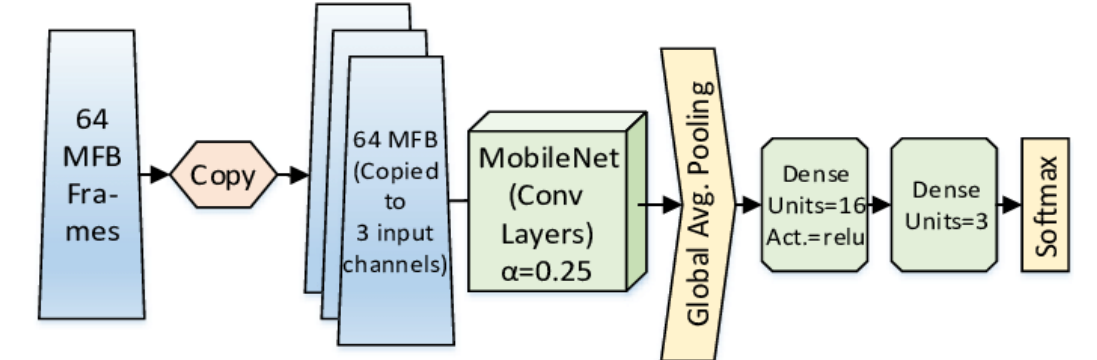
Figure 2. The architecture of the MobileNet model.